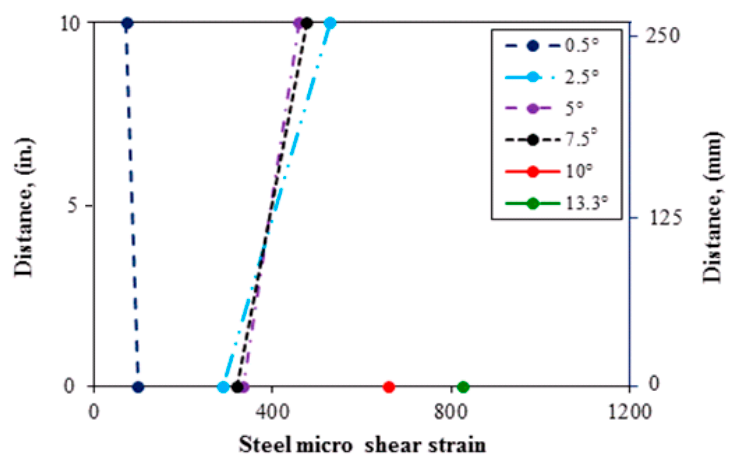
Figure 12. Shear strain profile on the steel tube from the surface of the footing.